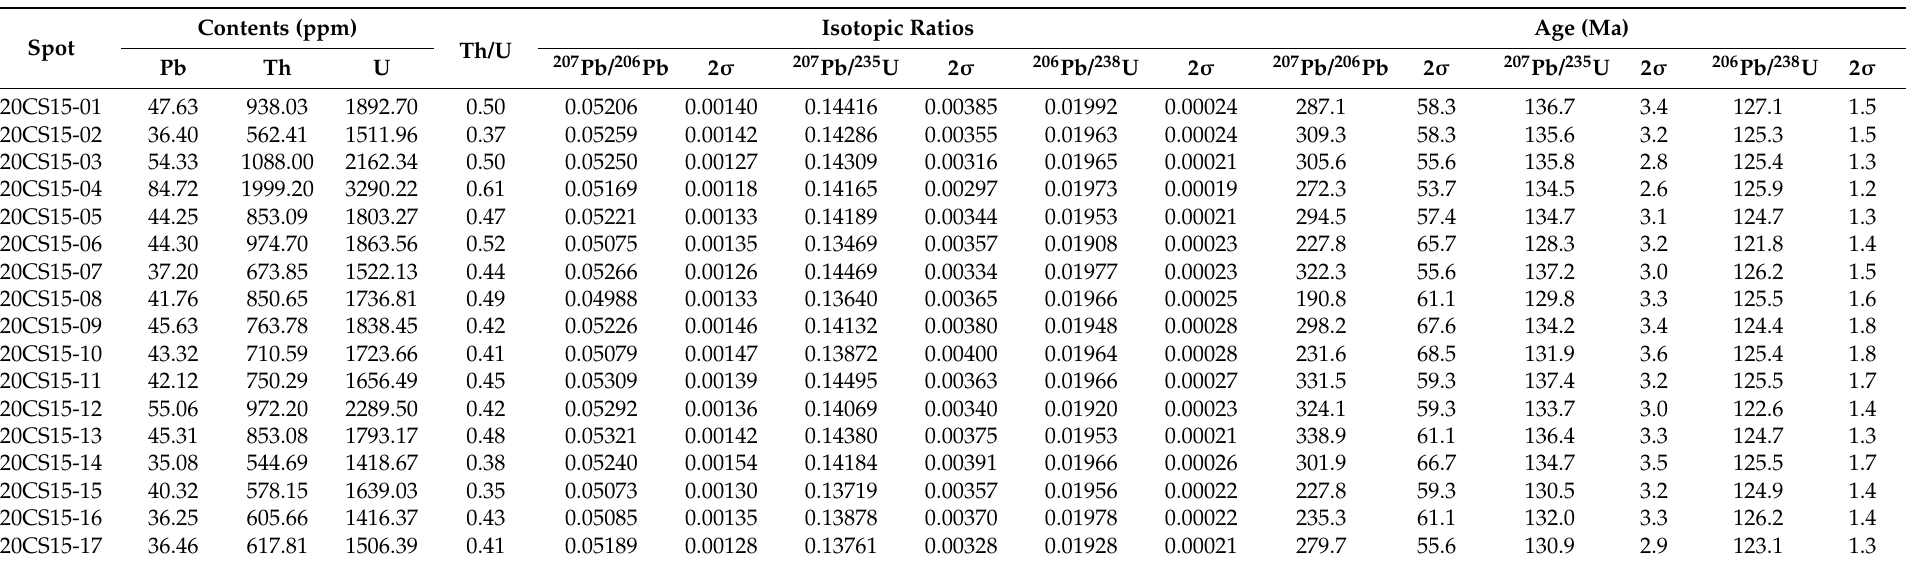
Table 2. LA-ICP-MS zircon U-Pb isotope data for kersantite (20CS15) from the Weishan